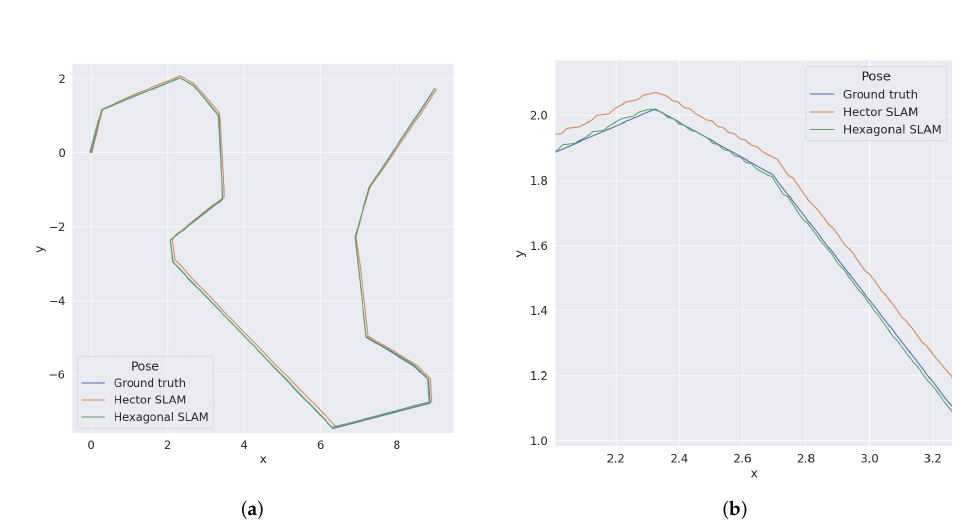
Figure 8. Ground truth position and position estimations for Test 1. ( a ) The whole test run. ( b ) Close up.